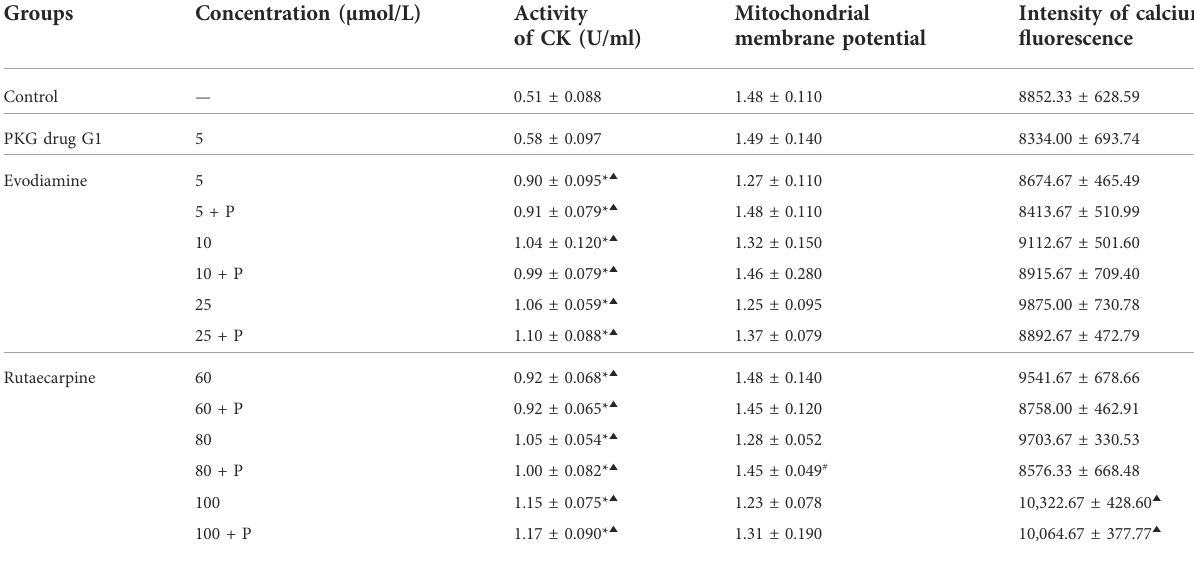
TABLE 3 Cell cytotoxicity of evodiamine and rutaecarpine plus PKG drug G1 ( n = 4, ‾ x ± s ).